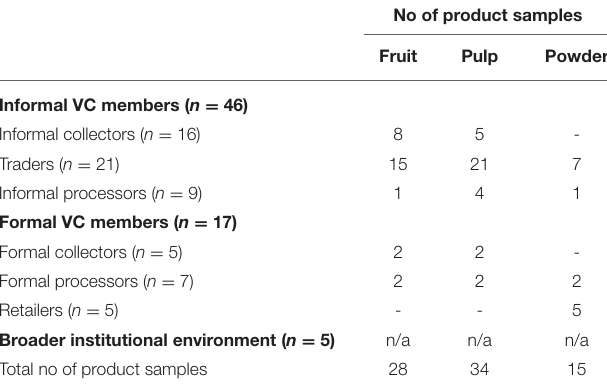
TABLE 1 | Overview of interviewed stakeholders and samples